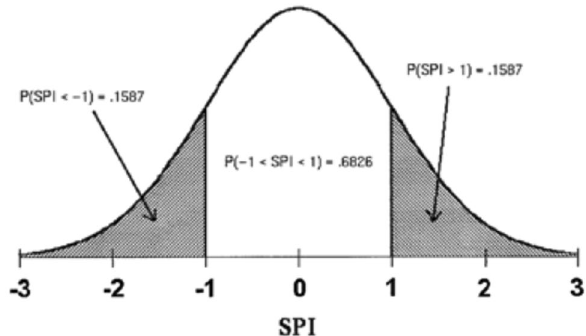
Fig. 2 Probability of occurrence of standard normal distribution of SPI values (Edward and McKee,